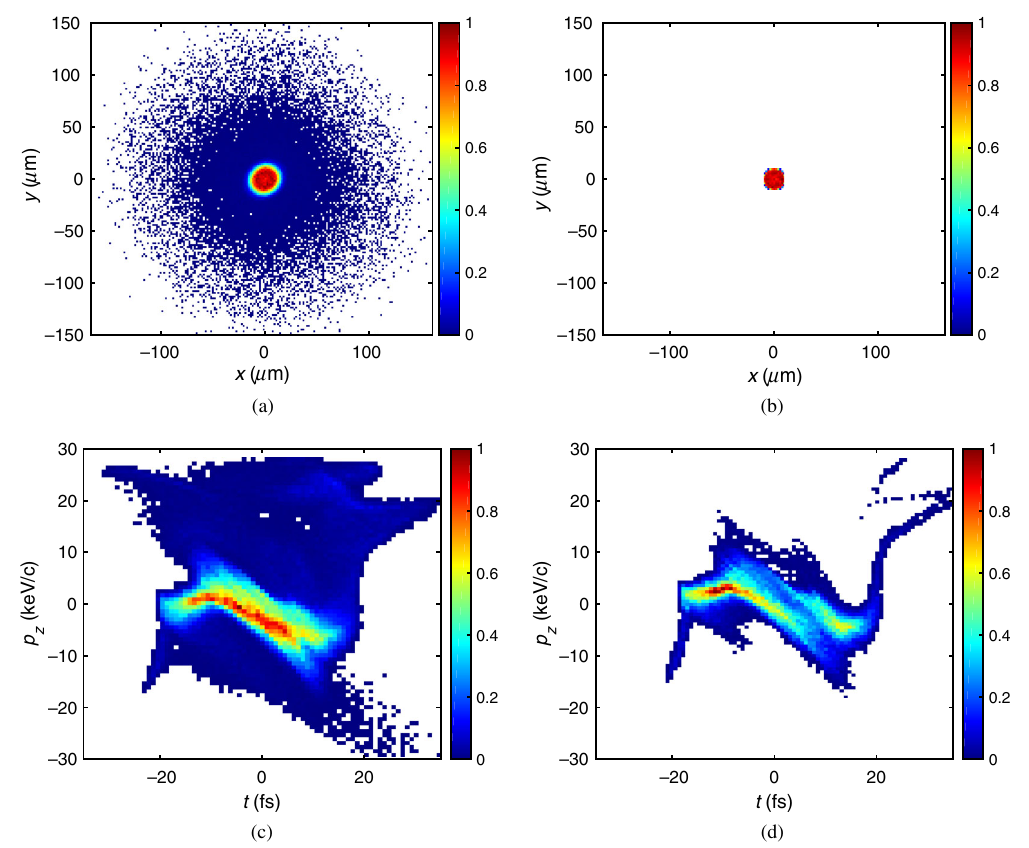
FIG. 8. Bunch transverse distribution and longitudinal phase space before and after going through the aperture at the sample location at a final charge of 10 5 electrons = pulse. After the aperture, the bunch had an emittance of 2.6 nm, beam width of 5 μ m, and bunch length of 10 fs. (a) Transverse distribution before aperture. (b) Transverse distribution after aperture. (c) Longitudinal phase space before aperture. (d) Longitudinal phase space after aperture.